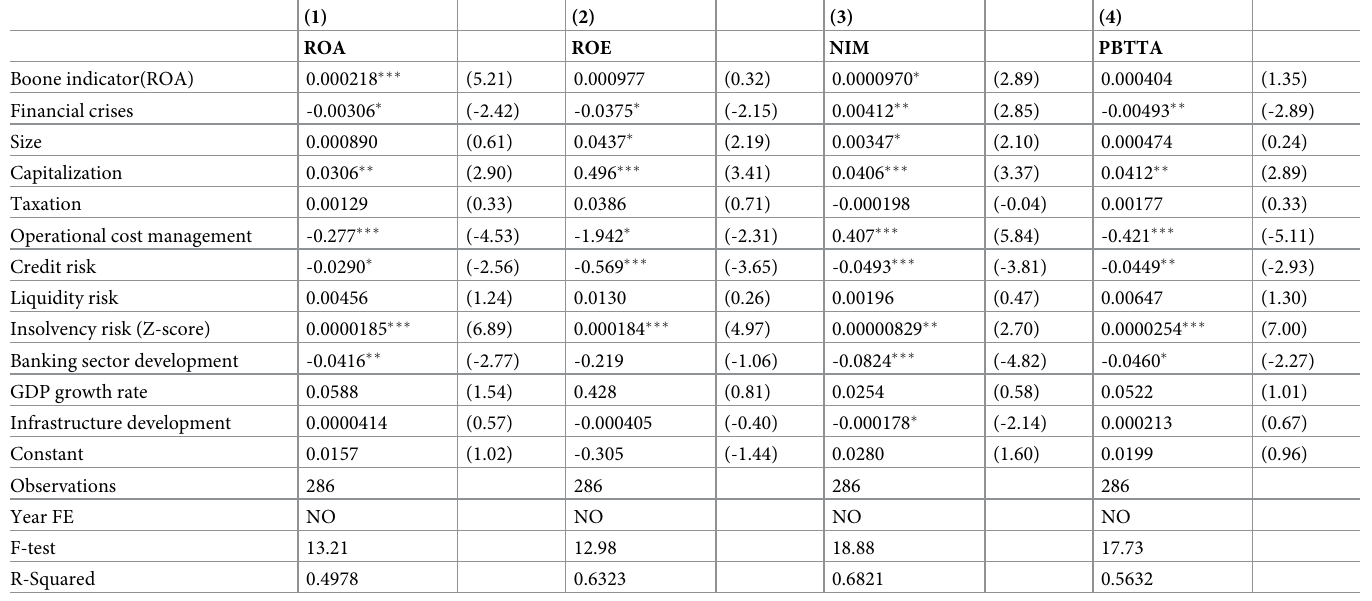
Table 10. Fixed effect model when the competition is measured through the Boone